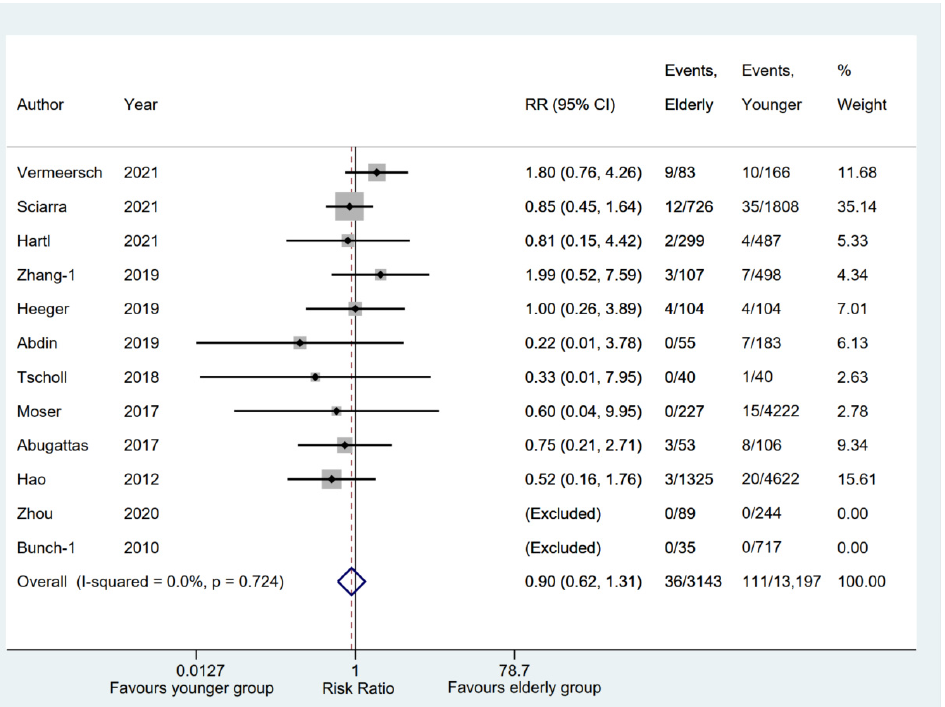
Figure 9. Forest plot comparing all-cause death between elderly and younger groups [6,12–14,16–19,22–25,27,29]. The dotted red line represents the pooled risk ratio for all-cause death between elderly and younger groups.